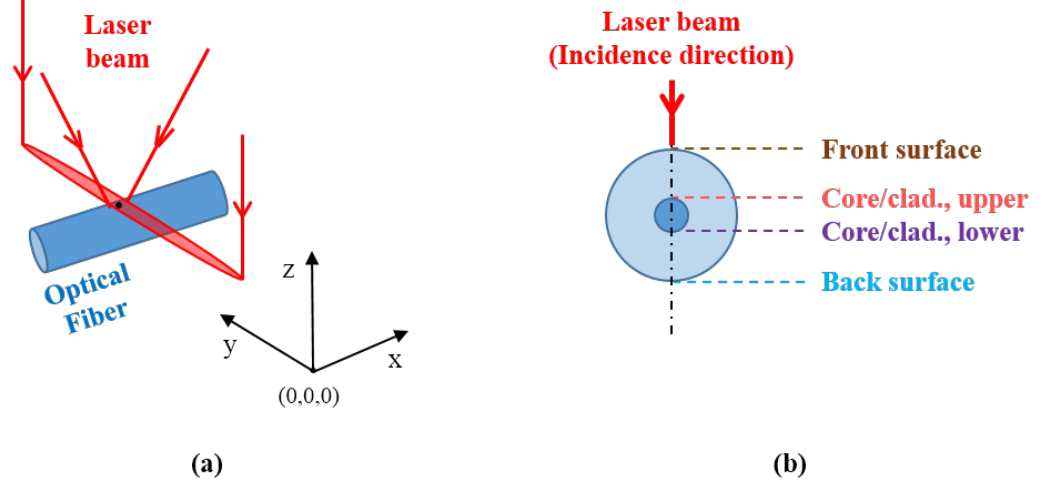
Figure 1. Schematics of ( a ) coordinates used in this work and ( b ) main physical interfaces. The origin of the reference system is in the middle of the laser